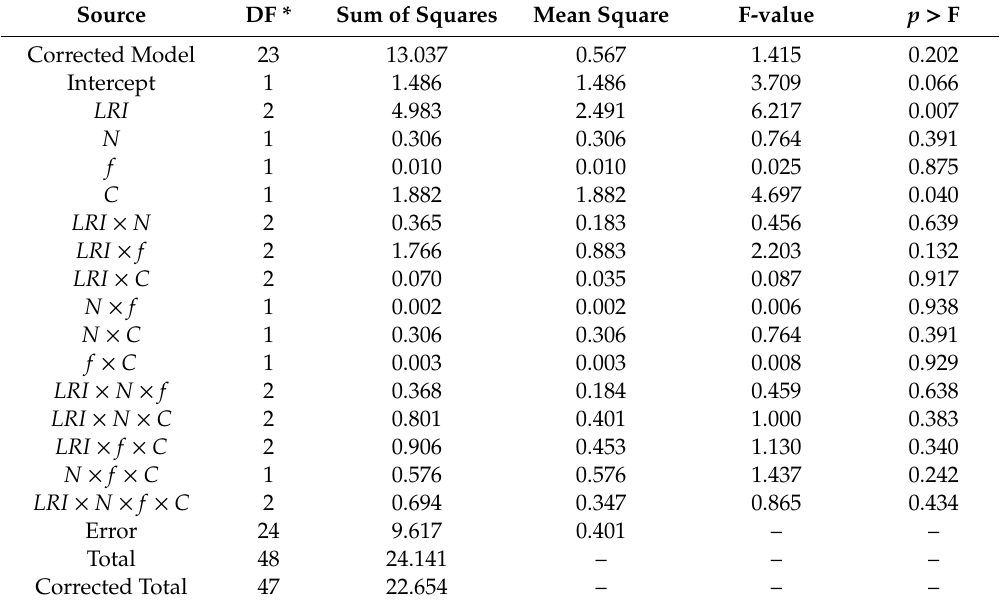
Table 9. Outcome of the first iteration for the ANOVA over Ln Ra